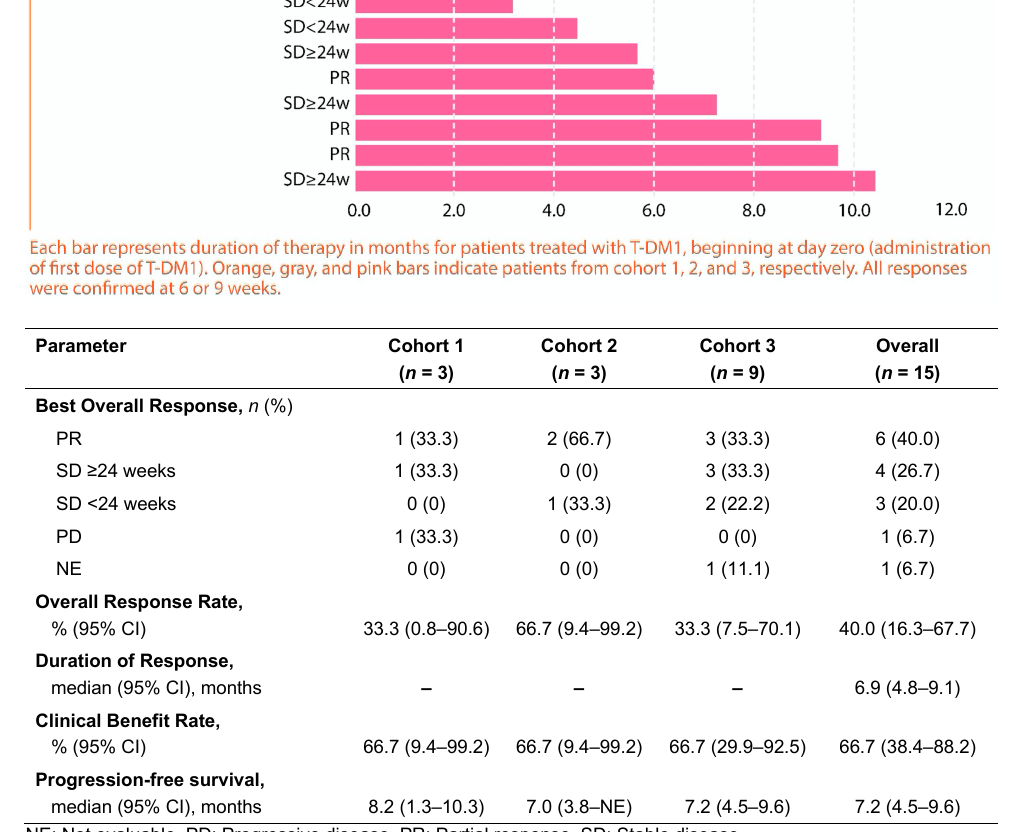
Figure 1. Antitumor clinical activity of the combination of T-DM1 and NPLD.